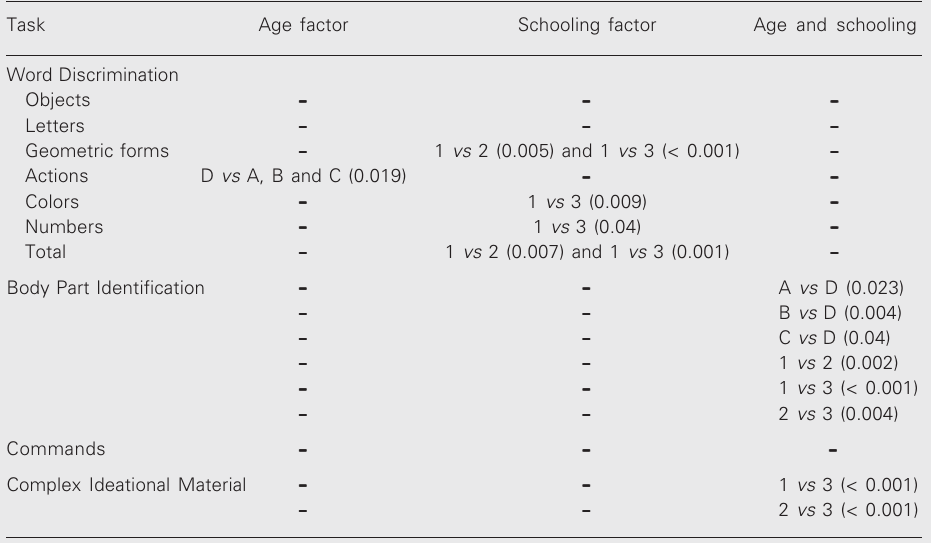
Table 6. Results of multiple comparisons showing inter-group differences and the respective level of significance for each task (MANOVA with Dunnett post-test).